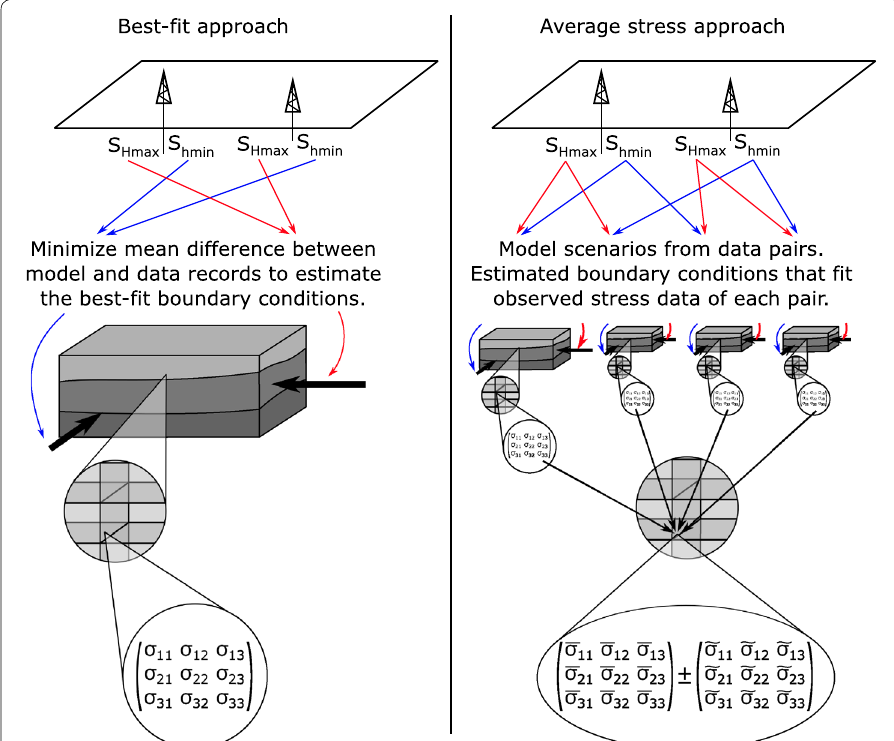
Fig. 3 Best‑fit modelling approach (left) vs. average stress state with uncertainty quantification approach (right) of geomechanical–numerical modelling. In a best‑fit approach the difference between the modelled and observed stress magnitudes is minimised. The uncertainty quantification approach combines each S hmin with each S Hmax magnitude and thus generates several model scenarios that are each adjusted to fit an individual pair of calibration stress data records. From all of these model scenarios, the average and its standard deviation of the full stress tensor is computed at each node throughout the model volume